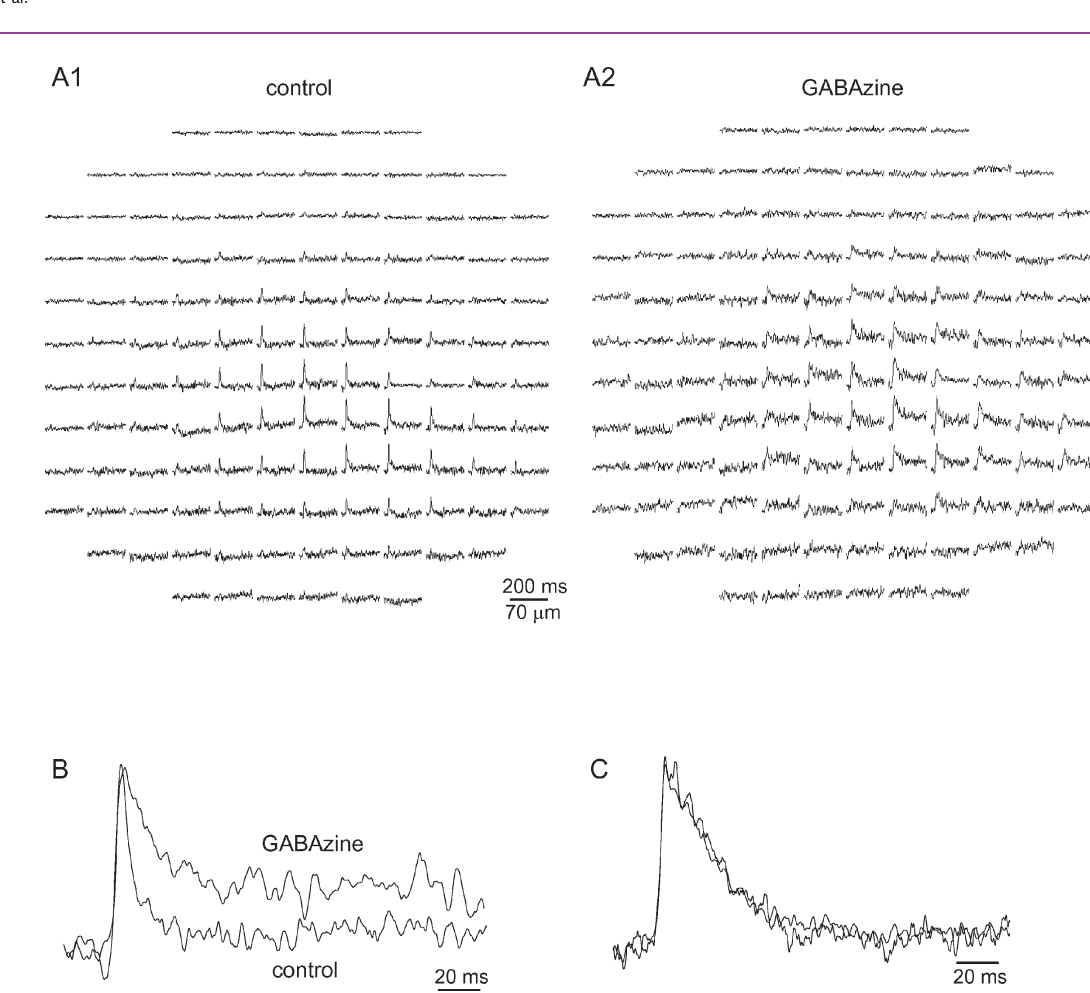
Figure 6. GABAzine prolongs mossy fiber responses without affecting their spatial distribution. ( A ) The optical response to MF stimulation before A1, and after A2, application of GABAzine (300nM). ( B ) The average traces from four diodes in the center of the responses in A are normalized and shown in an enlarged scale. Note the significant prolongation of the response. ( C ) The average traces from 10 diodes in the center of a response to climbing fiber stimulation before and after application of GABAzine